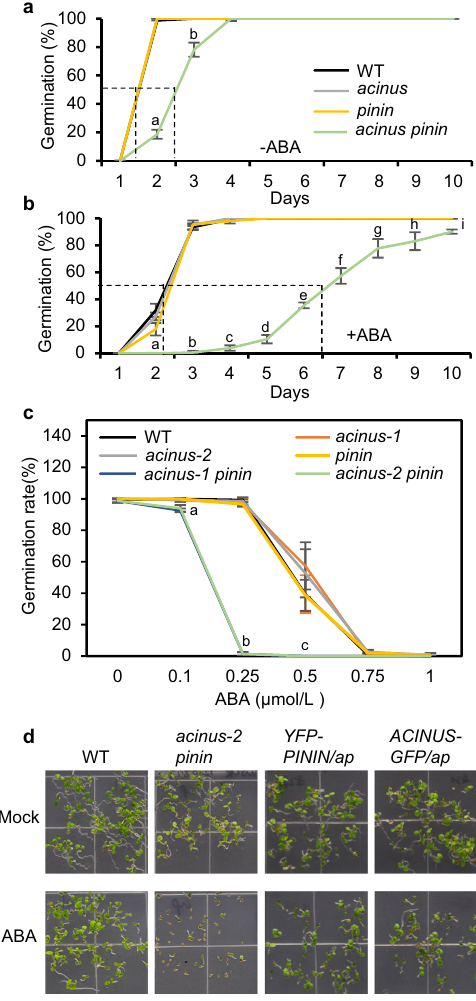
Fig. 2 The acinus pinin double mutants showed ABA hypersensitive phenotypes. a , b Germination rates of WT, acinus-2 , pinin-1 , and acinus-2 pinin-1 after different days on ½ MS medium without ABA ( a ) or with 0.25 μ mol/L ABA ( b ). The data points of WT, acinus-2 , and pinin-1 overlap. Statistically signi fi cant differences between WT and acinus-2 pinin-1 were determined by two-tailed t test. The P values for a and b in a are 1.24E − 5 and 2.96E − 2. The P values for a, b, c, d, e, f, g, h, and i in b are 7.69E − 3, 5.60E − 6, 2.88E − 6, 3.92E − 4, 3.17E − 4, 6.00E − 3, 3.10E − 2, 4.77E − 2, and 8.57E − 3. c Seed germination rates of the indicated genotypes on ½ MS medium supplemented with increasing concentrations of ABA after 5 days. Note that the data points of acinus-1 pinin-1 and acinus-2 pinin-1 overlap and those of WT, acinus-1 , acinus-2 , and pinin-1 overlap. Statistically signi fi cant differences between WT and acinus-2 pinin-1 were determined by two-tailed t test. The P values for a, b, and c are 3.51E − 2, 5.14E − 8, and 2.99E − 2. d Seed germination and development of the indicated genotypes on ½ MS medium with or without 0.5 μ mol/L ABA. The pictures were taken 6 days after germination. Values represent mean ± SD calculated from three biological replicates ( n = 3) for a – c . indicates that seed germination of the acinus-1 pinin-1 and acinus-2 pinin-1 double mutants is about threefold more sensitive to ABA than WT and the acinus and pinin single mutants (Fig. 2c). Similarly, post-germination seedling growth of acinus-2 pinin-1 was more inhibited by ABA (Supplementary Fig. 4a). These ABA-hypersensitive phenotypes were rescued by expres- sion of either AtACINUS-GFP or YFP-AtPININ in the acinus-2